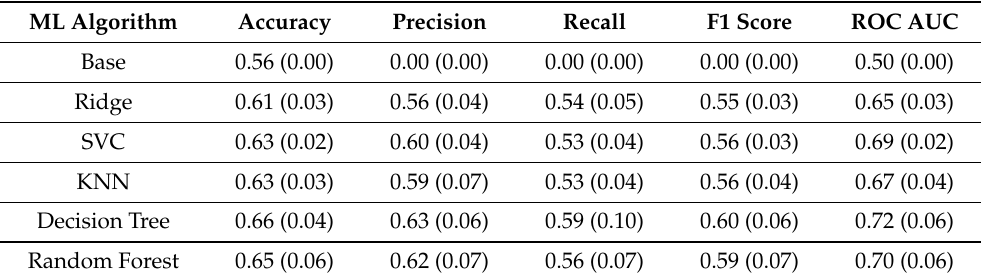
Table 10. HO prediction results (classification problem) using I-F features. Nested cross-validation with 10 outer and five inner splits. Classification problems on two classes: (a): High_HO (High Hedonic Orientated) and (b): Low_HO (Low Hedonic Oriented). Numbers are the mean value of 10 outer splits. Numbers in parenthesis indicate the standard deviation values.